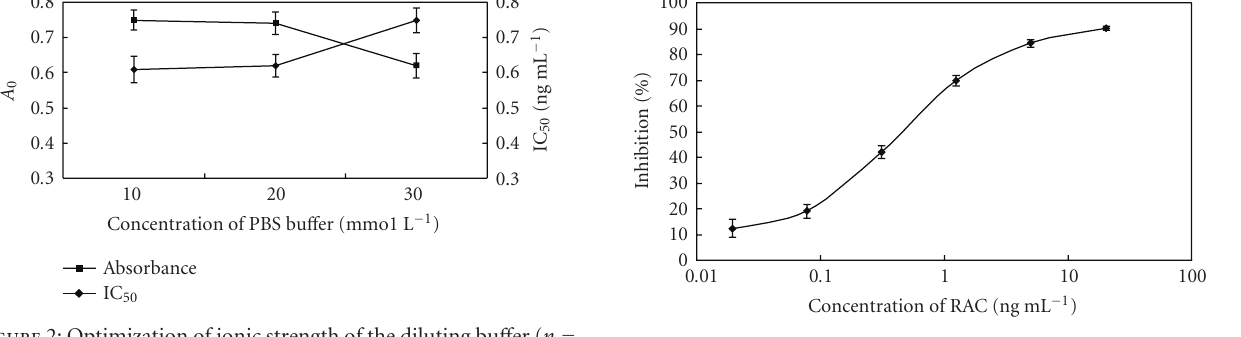
Figure 4: Standard curve of ractopamine in PBS bu ff er ( n =